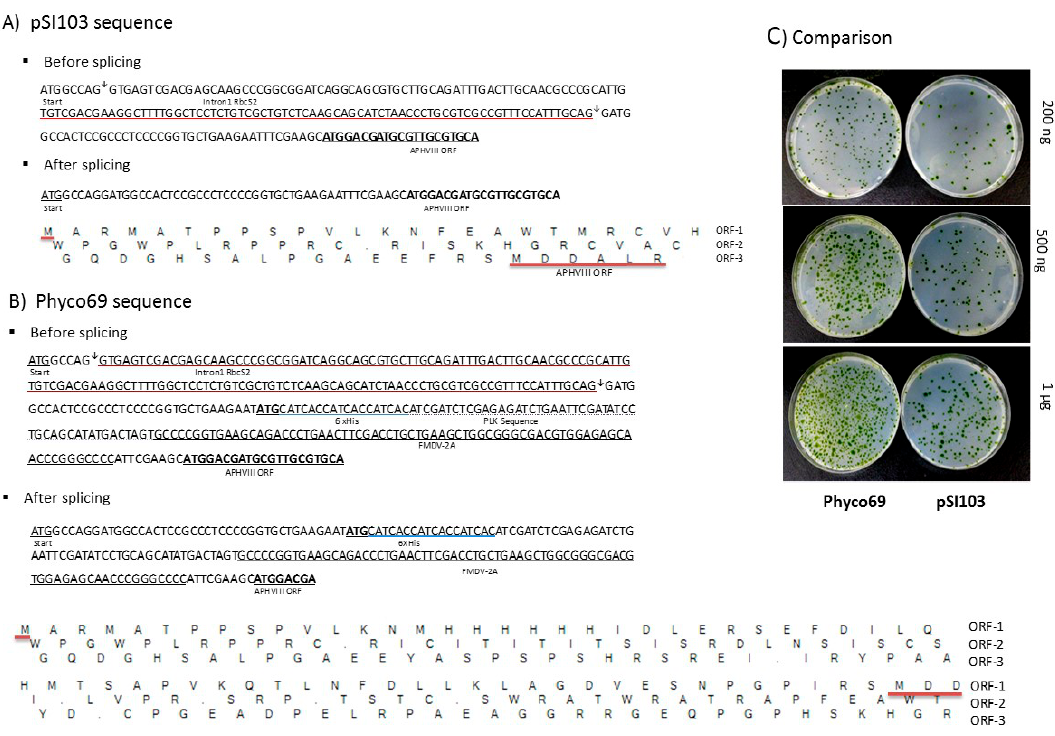
Figure A1. Detailed sequences flanking the start codon of the APHVIII gene before and after splicing of the first RbcS2 intron in the control pSI103 ( A ) and Phyco69 ( B ) plasmids and amino acidic sequence of the proteins generated in the three possible reading frames. A comparison of the efficiency of the transformation of Chlamydomonas with different quantities of each plasmid is also shown ( C ).